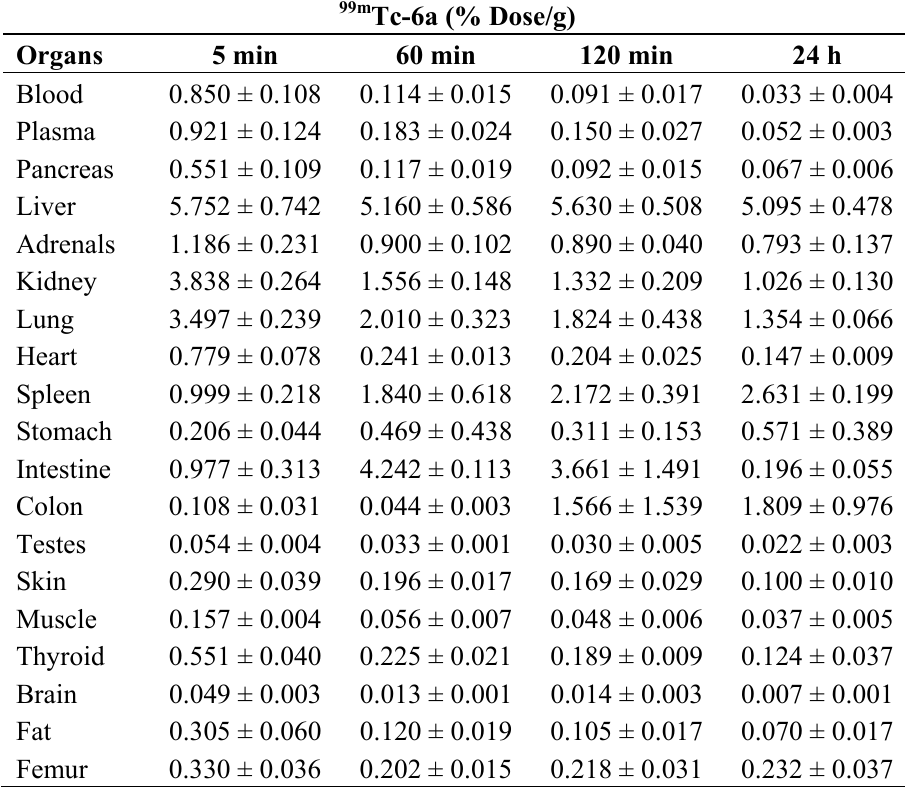
Table 2. Distribution of radioactivity in selected organs and systems of rats after intravenous administration of 99m Tc-6a